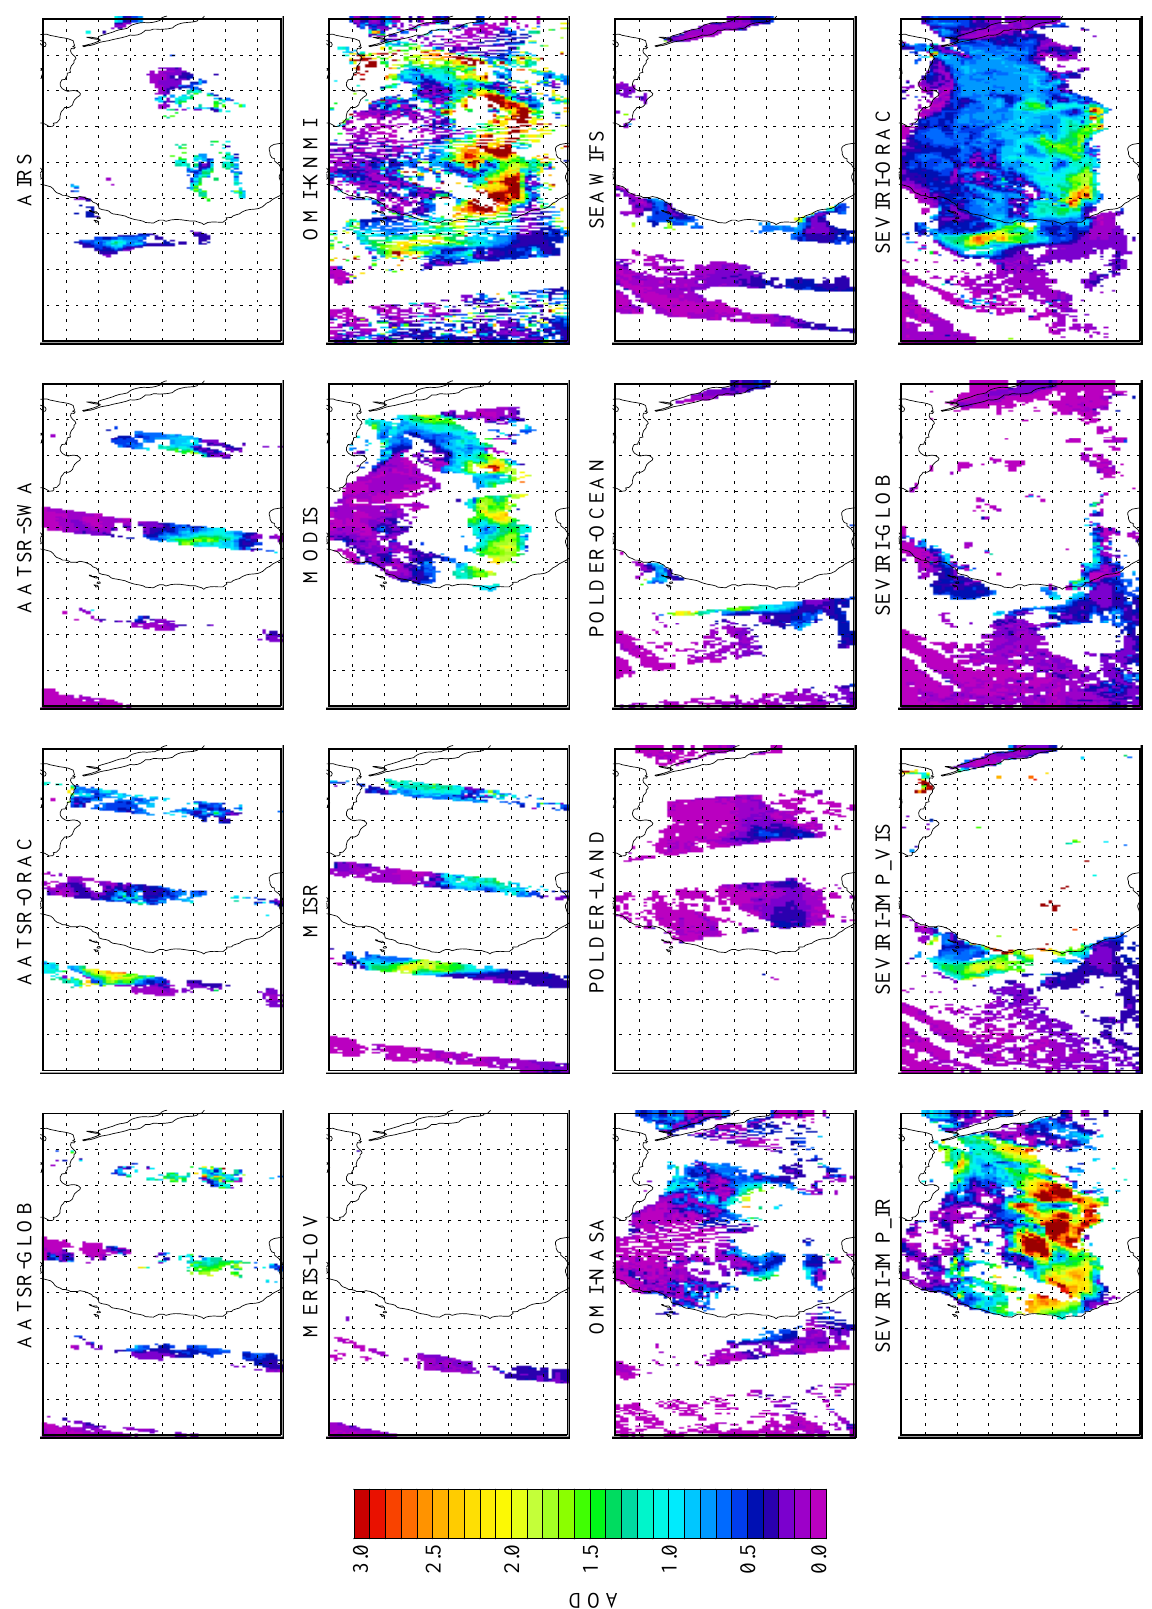
Fig. 1. Image of AOD of the different datasets corresponding to 8 March